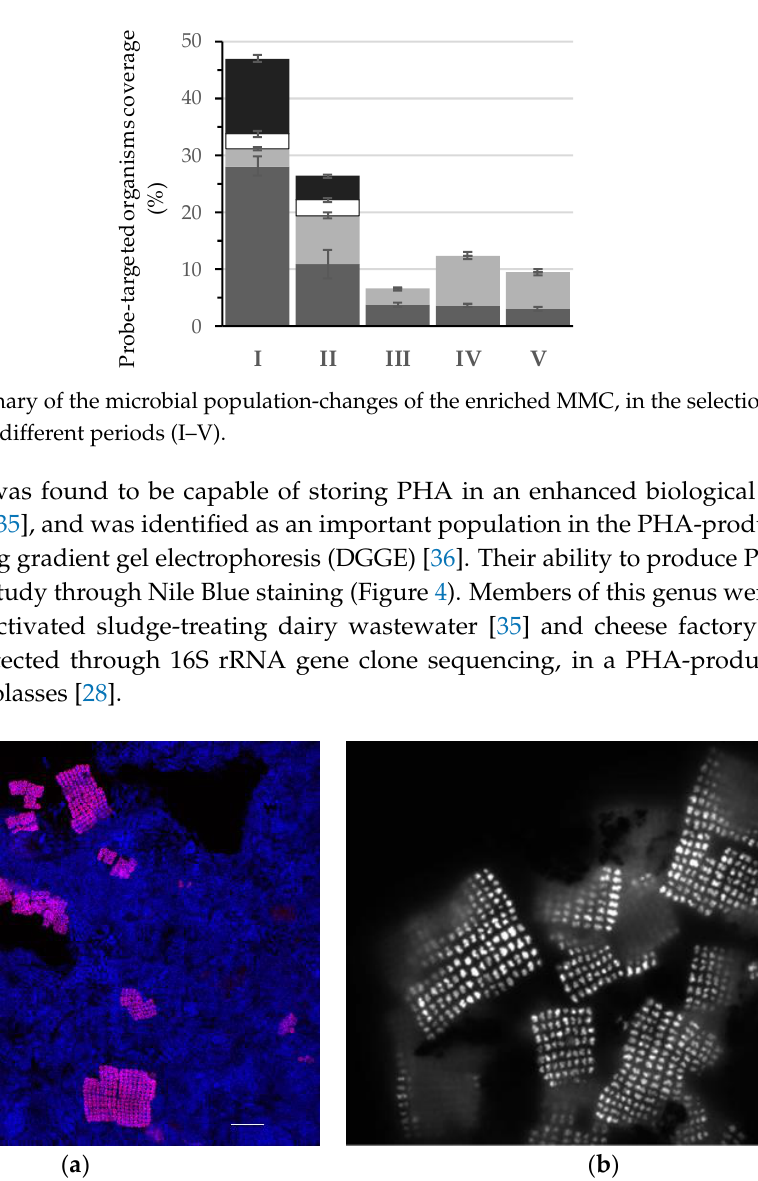
Figure 4. The typical tablet-shaped clusters of Lampropedia observed in this study: ( a ) FISH micrograph with Cy3-labelled Lampropedia ( magenta ) and Cy5-labelled Bacteria ( other Bacteria in blue ); and ( b ) Nile Blue staining. Bar = 10 μm.